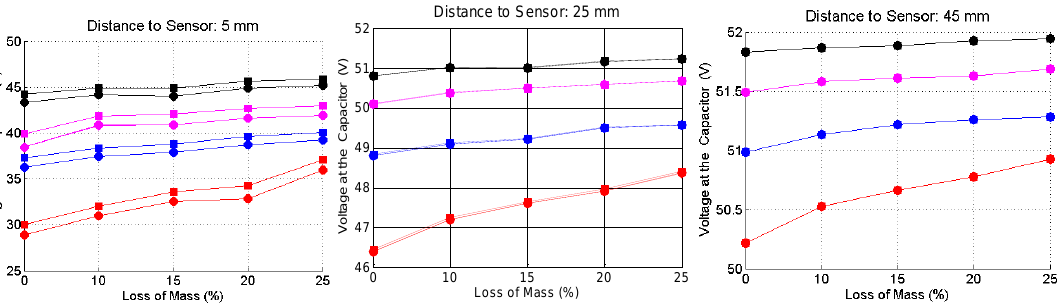
Figure 13. Measured voltage at the capacitive array for corroded (loss of mass equal zero) and non-corroded steel bars, as a function of the distance of the bar to the sensor. Red curves—20.0 mm bar gauge; Blue curves—16.0 mm bar gauge, magenta curves—12.5 mm bar gauge; and black curves—10.0 mm bar gauge.